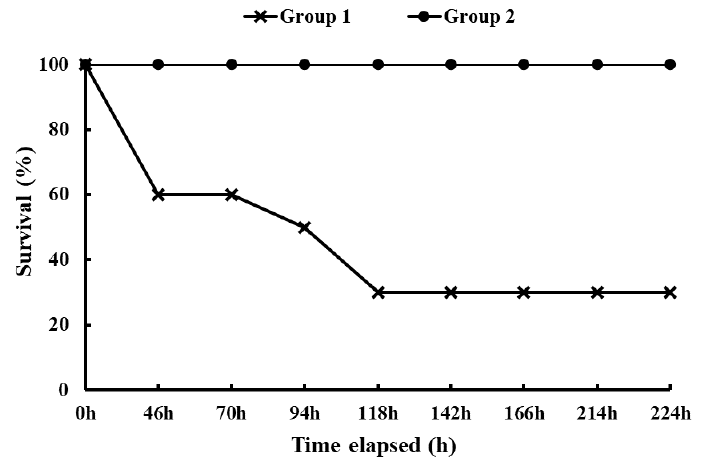
Figure 2. This Survival rate of Pacific white shrimp ( P. vannamei ) in an infectivity test involving feeding on frozen hepatopancreases infected with AHPND (group 1: Vp AHPND challenged; group 2: no challenge).